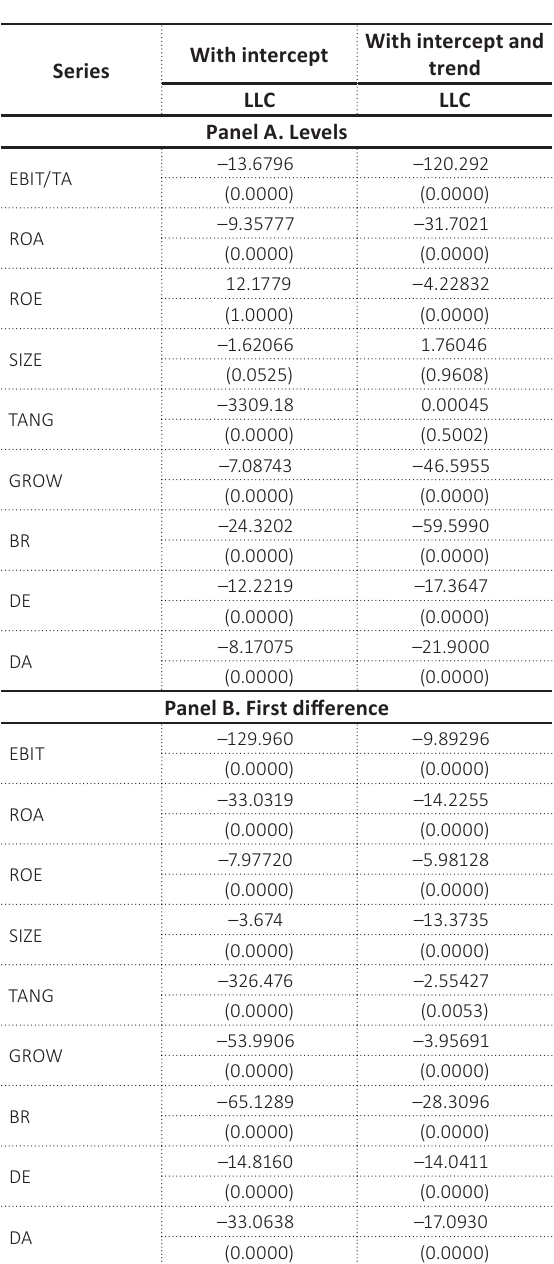
Table 3. Results of unit root test based on